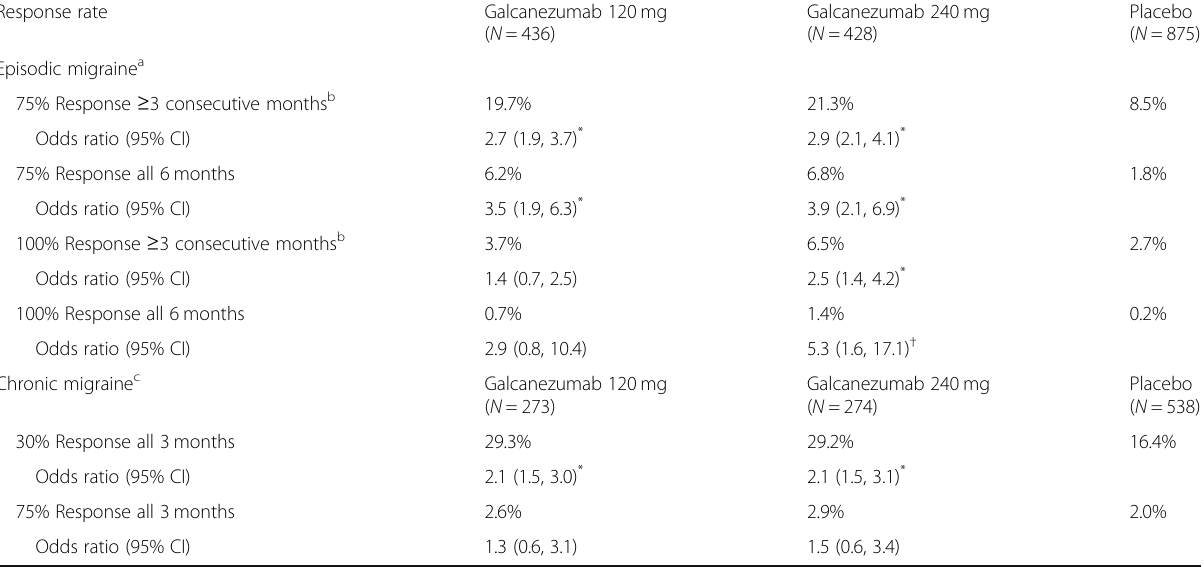
Table 3 Model-estimated proportion of patients with episodic and chronic migraine with maintained response Response rate Episodic migraine a